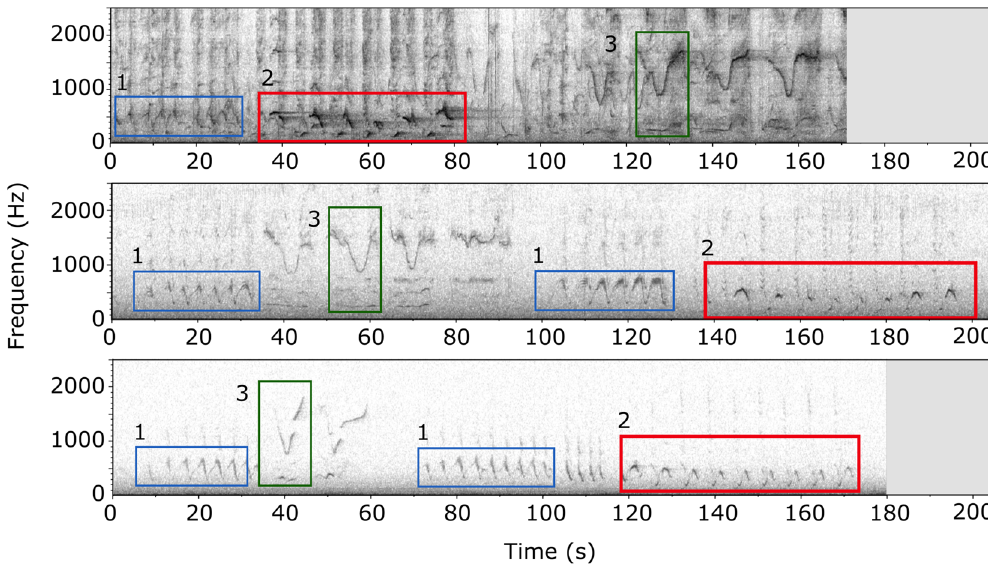
Figure 7. Examples of 3 bowhead whale songs recorded from the Greenland Sea. Top, song recorded in Northeast Greenland on the 11 of November 2013 (this study). Middle and bottom, songs recorded in the Fram Strait, respectively from November 2013 and December 2012 69 (Spectrogram parameters: 1024 pts FFT, 50% overlap, Hann window). The numbers correspond to a single unit or a sequence of units: 1 is a long frequency- modulated sound around 500 Hz with a distinctive growling on the highest parts of the signal; 2 is a sequence of alternating downsweep and upsweep units; 3 is a “V” shaped unit with a flat